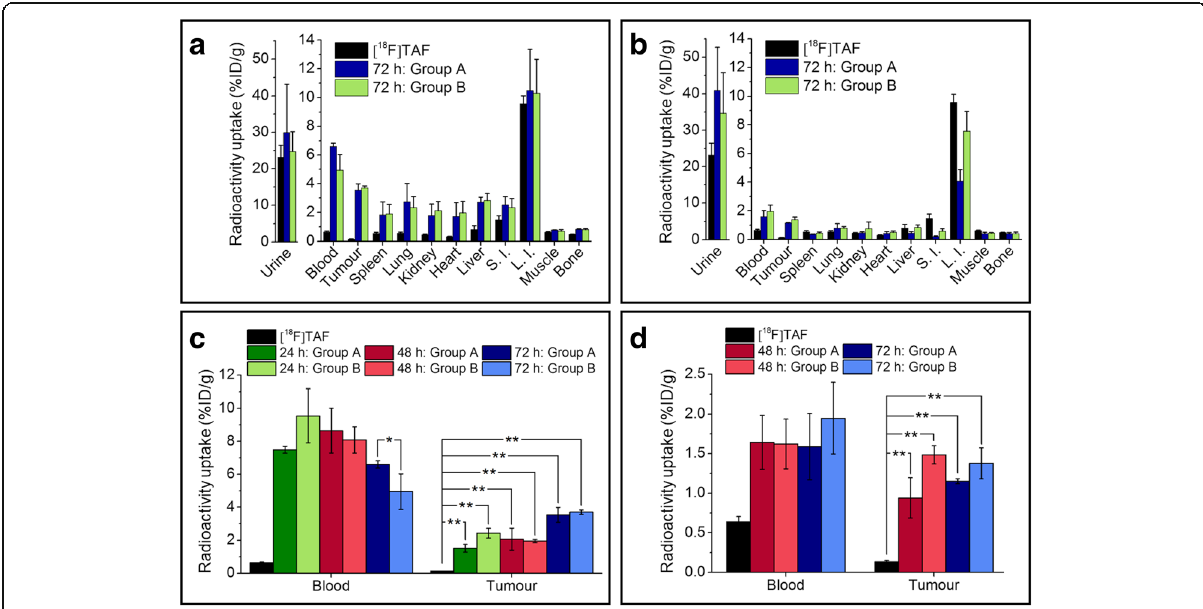
Fig. 5 The ex vivo biodistribution of [ 18 F]TAF and pretargeted cetuximab ( a , c ) and pretargeted trastuzumab ( b , d ) in groups A ( n = 4) and B ( n = 4). In a and b , the lag time between mAb and [ 18 F]TAF injection is 72 h. All the results presented are at 4 h after [ 18 F]TAF injection. The same molar amount of non-radioactive TAF was given to each animal either by adding it to the [ 18 F]TAF injection (group A) or by giving it 5 min prior to [ 18 F]TAF injection (group B). The values represent mean ± standard deviation. %ID/g = percentage injected dose/g. S.I. = small intestine, L.I. = large intestine. * p < 0.05 and ** p < 0.005 (two-tailed paired t test done with IBM SPSS Statistics 22)